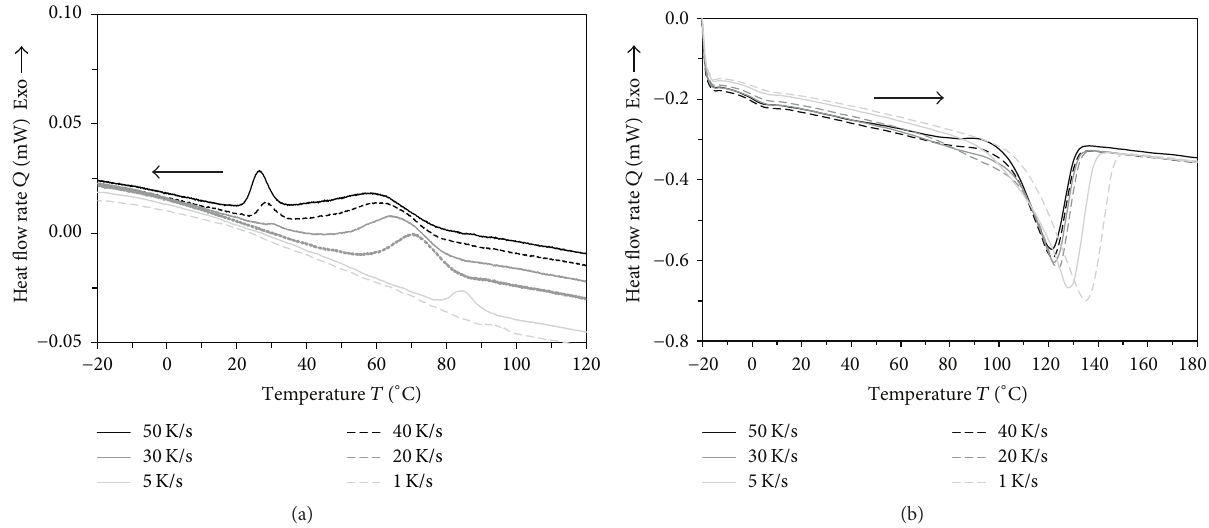
Figure 7: Heat flow rate measured during cooling (a) and second heating (b) of iPP with respect to the examined cooling velocities from 50 to 1K/s.